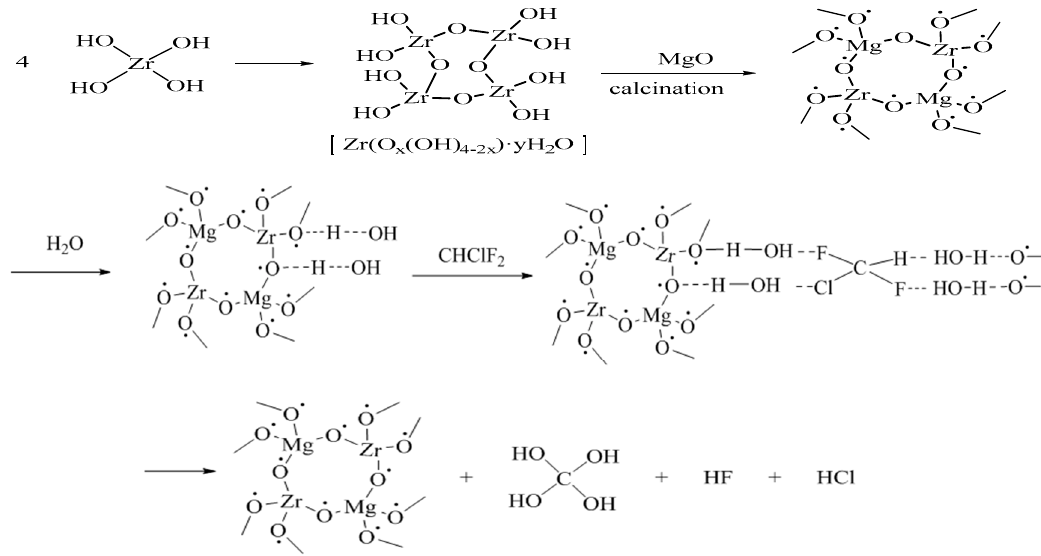
Figure 14. Schematic drawing of the synthesis catalytic hydrolysis of HCFC-22 by MgO/ZrO 2.